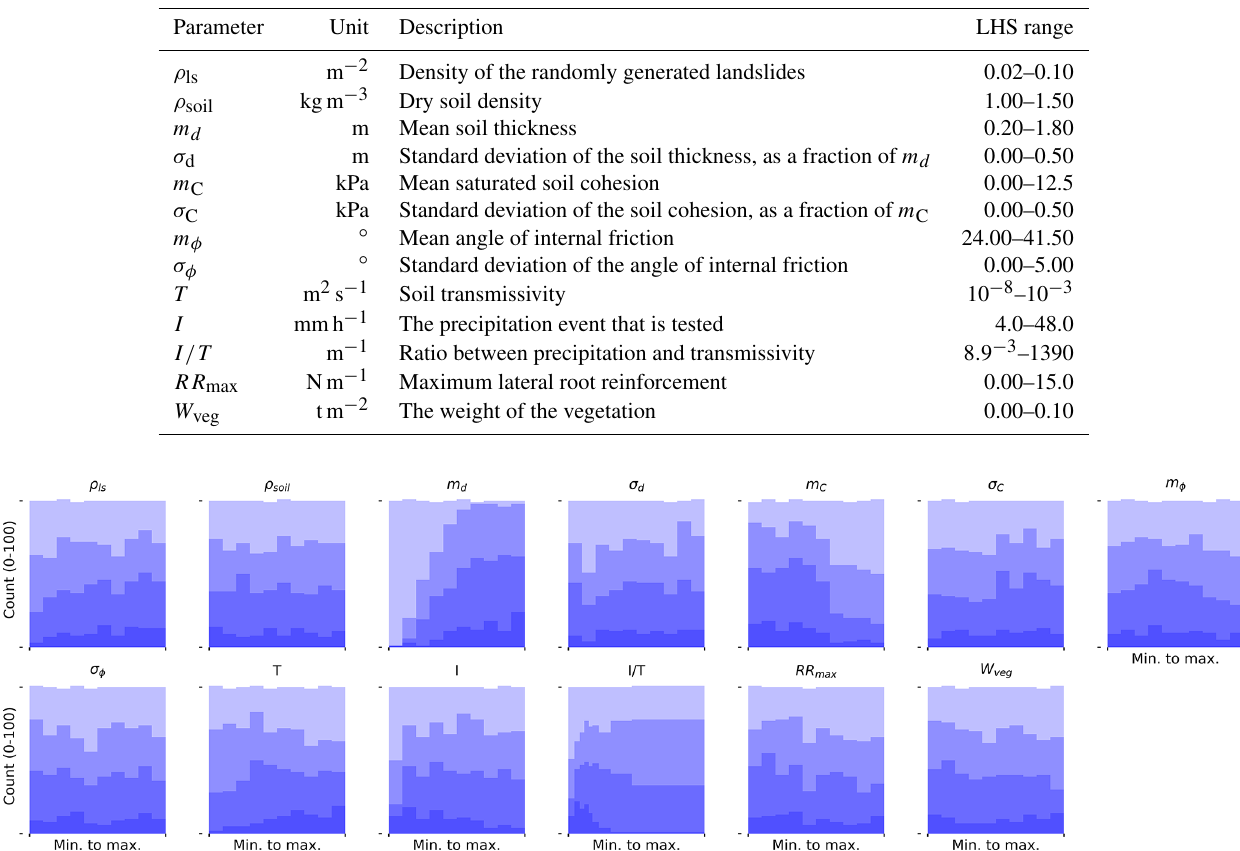
Table 6. Parameters used in the SlideforMAP qualitative sensitivity analysis and corresponding ranges for parameter sampling via LHS. RR max and W veg are given as spatially uniform parameters and are not computed by the methodology in Sect. 2.5. This is to create scenarios that are comparable with and without single-tree detection.